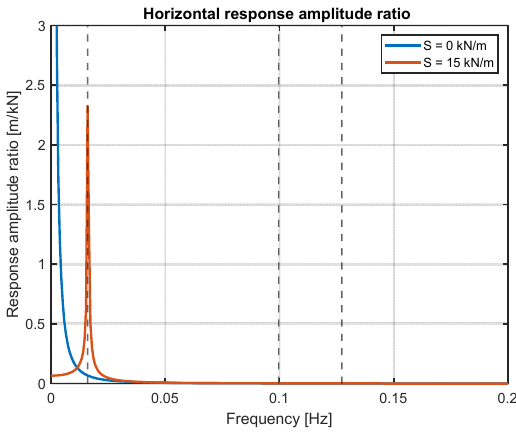
Figure 16. Case 1, Minimum diameter, pre-tension 10 kN.